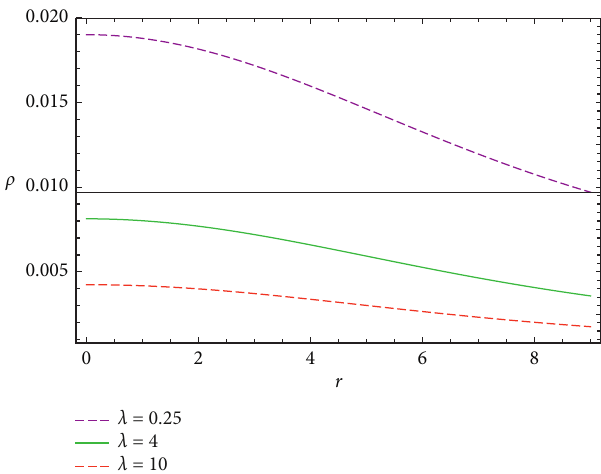
Figure 2: Behavior of ρ under one small and two large values of λ for Vela